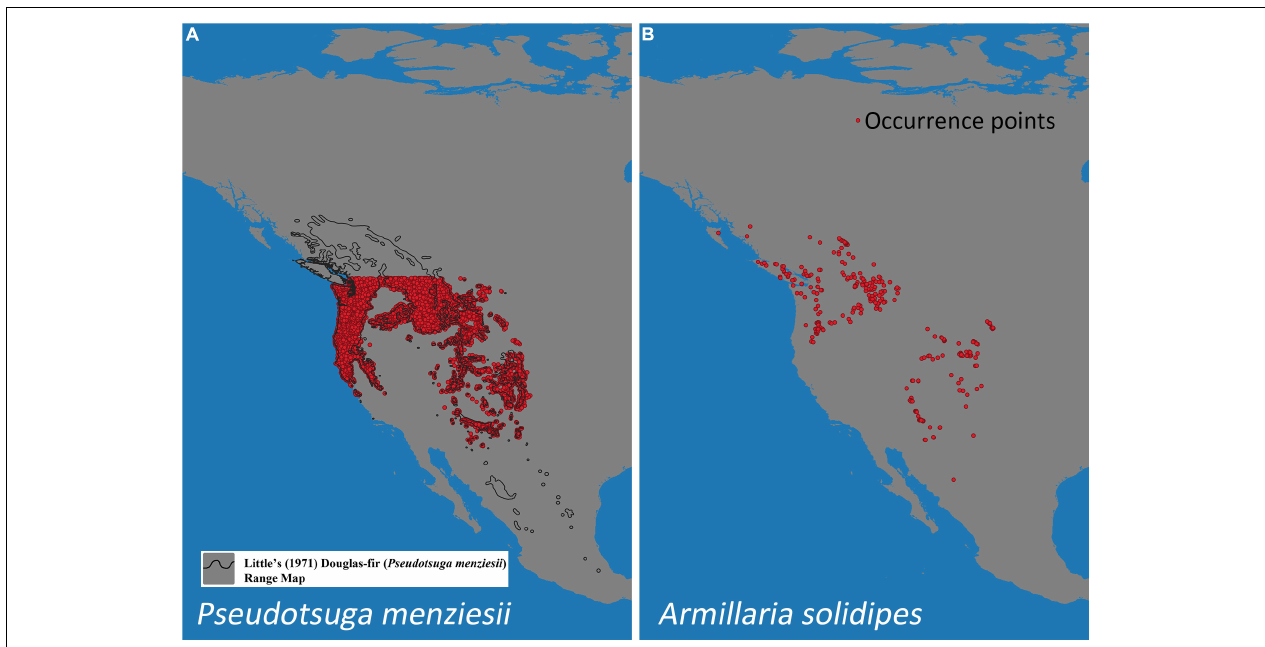
FIGURE 1 | Occurrence points of Pseudotsuga menziesii (A) and Armillaria solidipes (B) in North America. The black outline (A) designates Little’s (1971) P. menziesii range